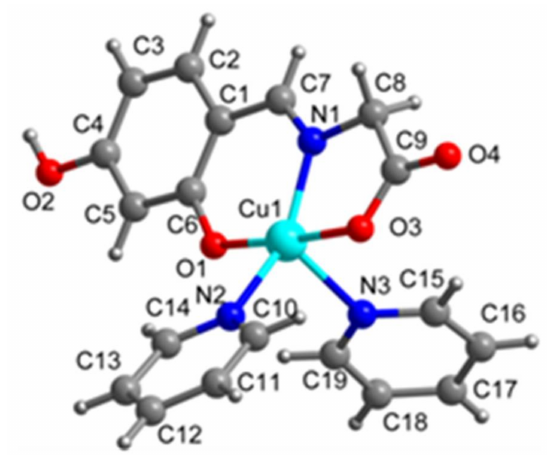
Figure 2. The crystal structure of Complex 2